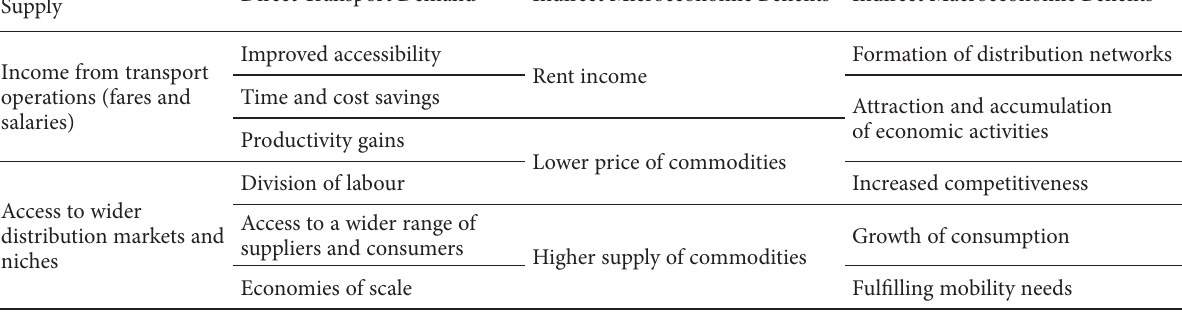
Table 1. Th e benefi ts of transportation to economy Direct Transport Supply